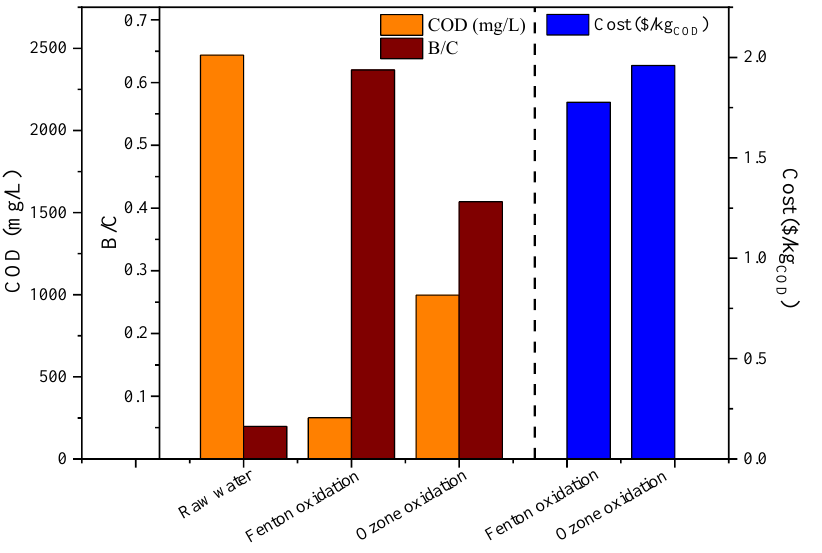
Figure 5. Comparison of COD, B/C values, and treatment costs in different Fenton and ozone oxidation systems.